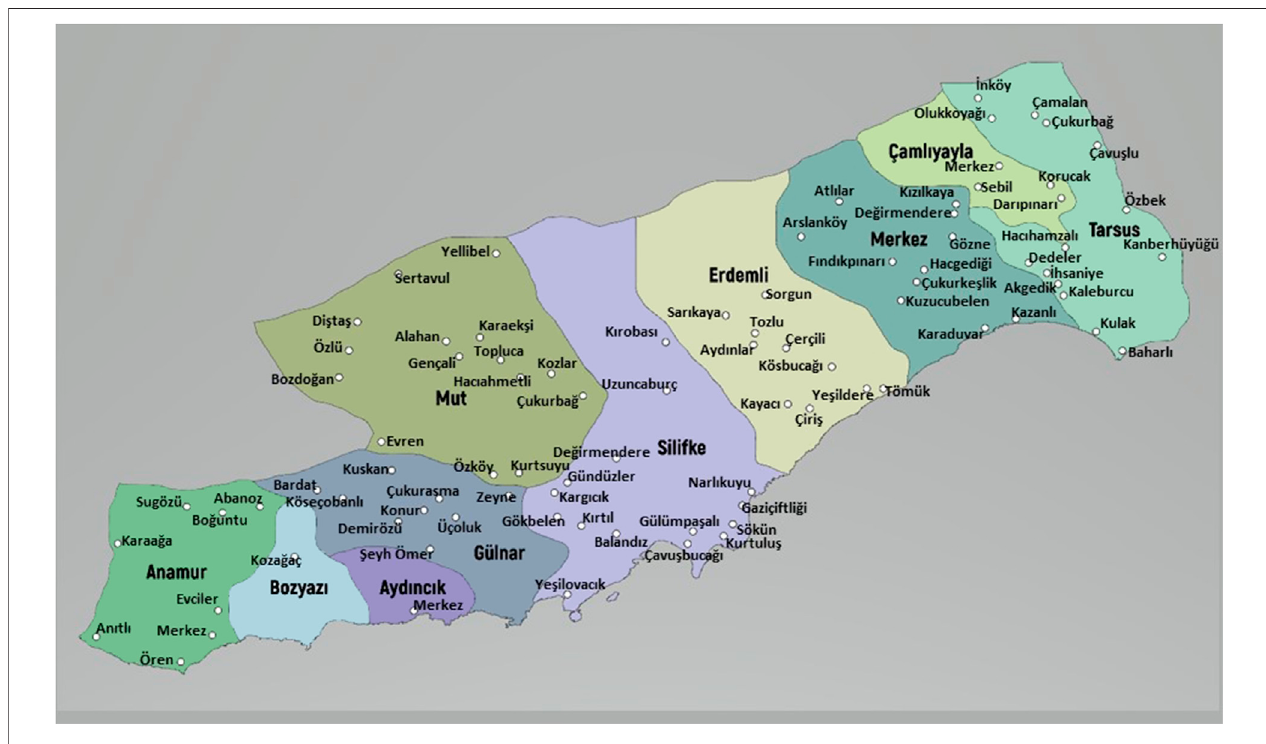
FIGURE 2 | Map of visited villages of study area.